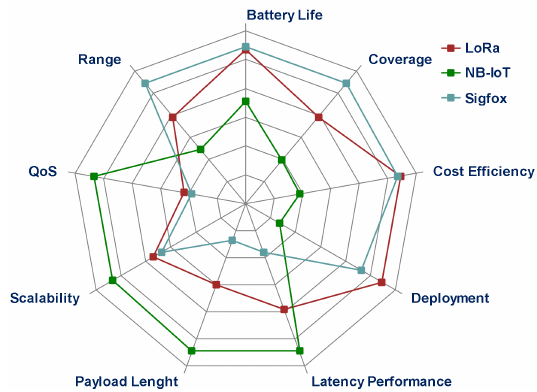
Figure 1. LPWAN protocols benefits in IoT